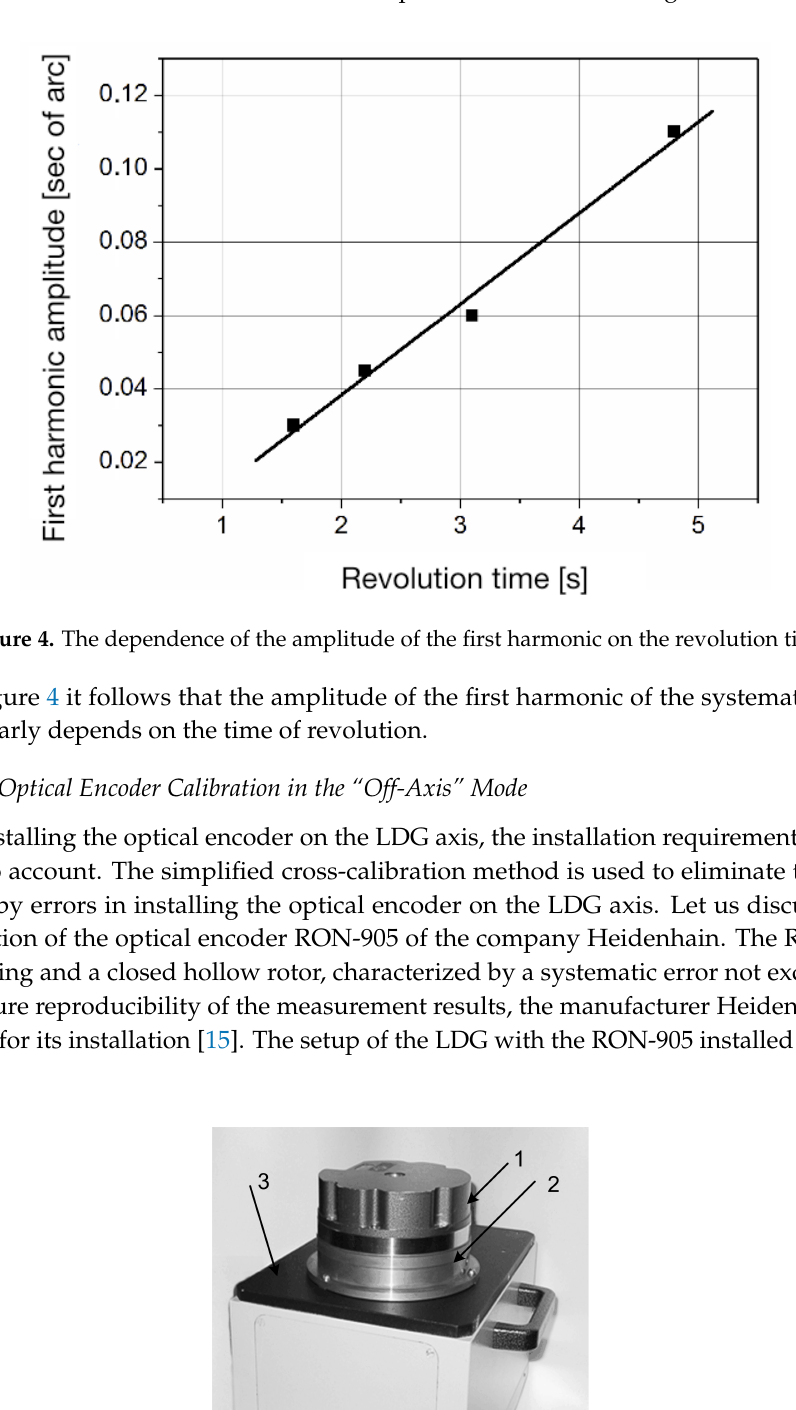
Figure6. TheresultsofRON-905calibrationwithrotationoftherotorinCW(2)andCCWdirection(1)